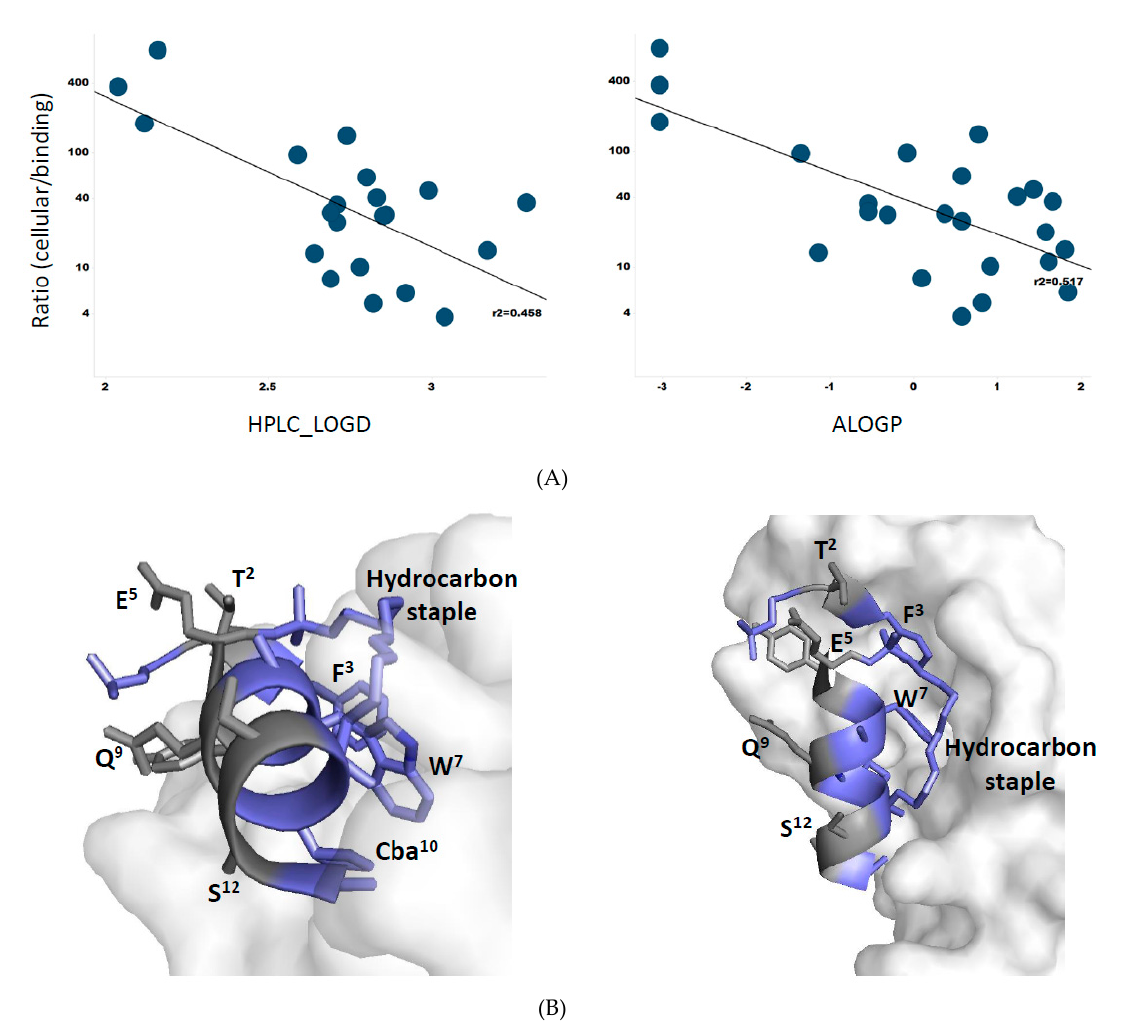
Figure 7. ( A ) Correlations between cellular/biochemical ratios (see Tables 1 and 2) and lipophilicity determinations; HPLC-LogD (Left panel) and ALogP (Right panel). ( B ) α -Helical structure of ATSP-7041 showing it amphipathicity in terms of hydrophobic surface in blue (F 3 , W 7 , Cba 10 , hydrocarbon staple) that is interacting with Mdm2, whereas the hydrophilic surface in gray (T 2 , E 5 , Q 9 , S 12 ) is exposed to the solvent. The X-ray crystal structure of ATSP-7041 complexed with Mdmx (PDB code, 4N5T) was used for this analysis.